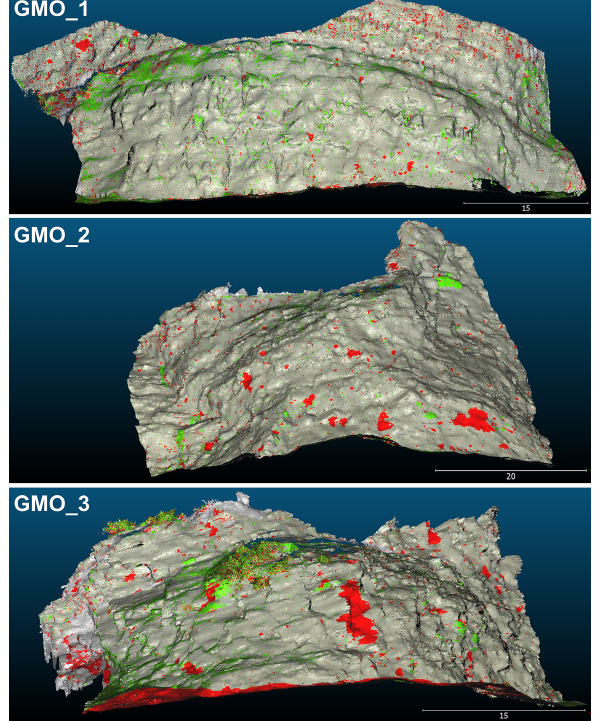
Figure A2. Point cloud of main changes between the first (14 June 2019) and last (18 December 2020) scan surveys of three GMO sites. Red points show negative changes; green points show positive